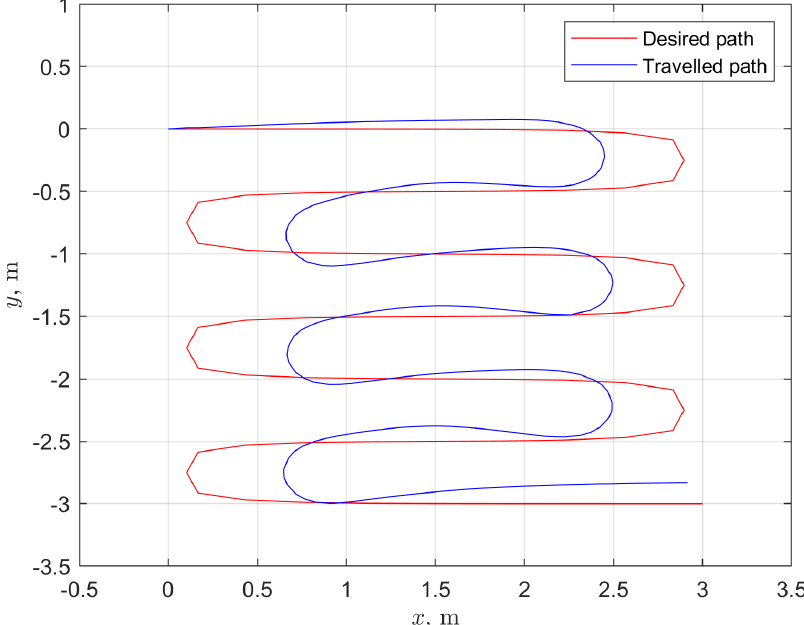
Figure 11. Desired path vs. actually traveled path for the lowest value of the cost function equal to 1—track 1.